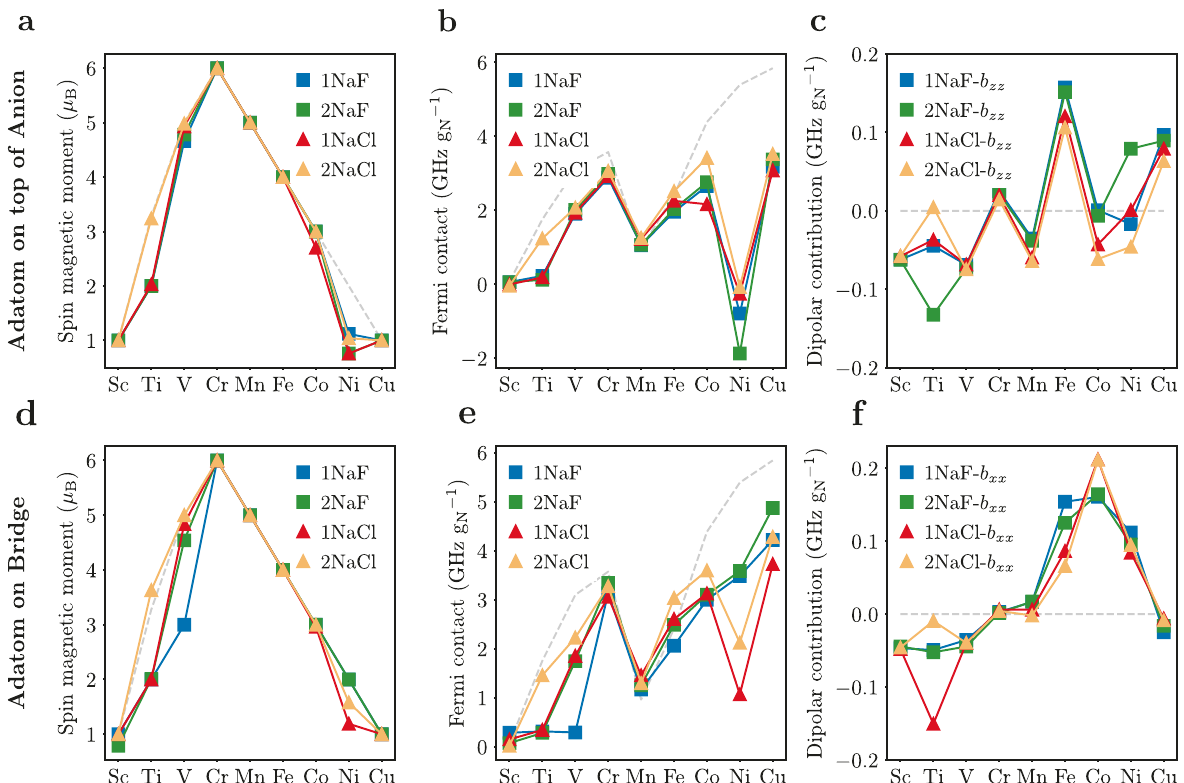
Fig. 6 Magnetic properties of adatoms on NaF and NaCl ultra-thin fi lms. Adatoms placed on top of anion ( a – c ) and on the bridge position ( d – f ). a , d Spin magnetic moment, b , e Fermi contact and c , f dipolar contributions to the hyper fi ne interaction. The number to the left of NaF and NaCl in the legend indicates the number of layers in the ultra-thin fi lm. The gray dash line represent the free-atom